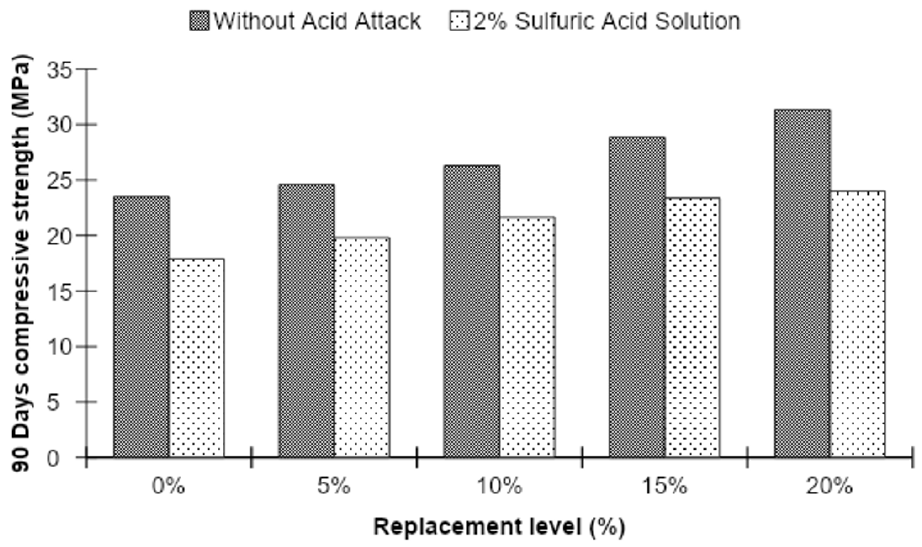
Figure 18. The 90-day compressive strength before and after acid attack for different MK contents.